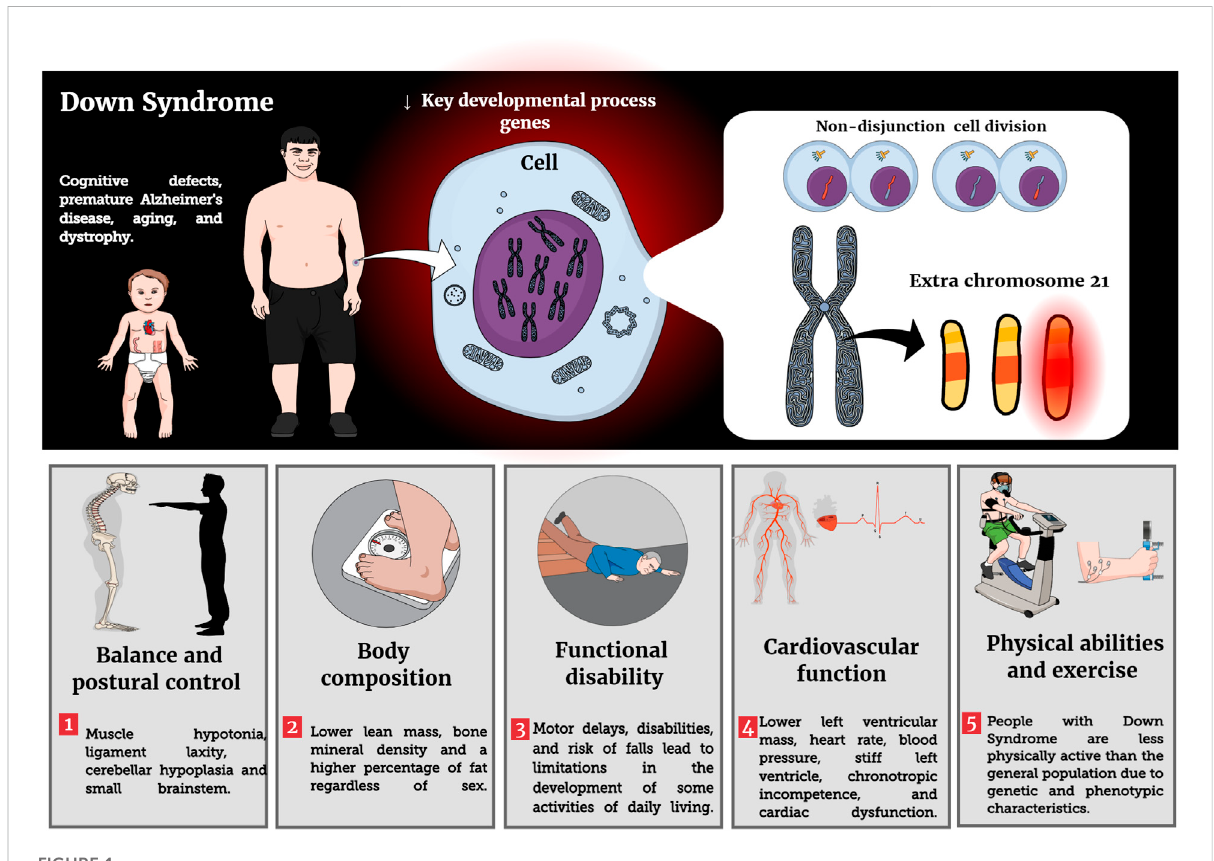
FIGURE 1 Effects of Down Syndrome on structural and functional